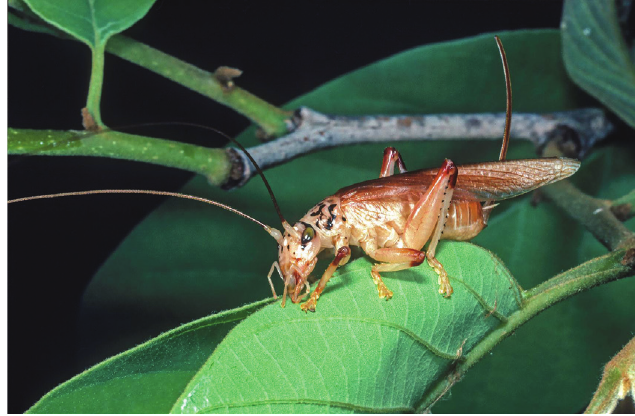
Fig. 5. Stictogryllacris sp. ( lyrata ?) from Highveld riverine habitat in Malolotja Nature Reserve, Eswatini (Swaziland). Body length about 15 mm.